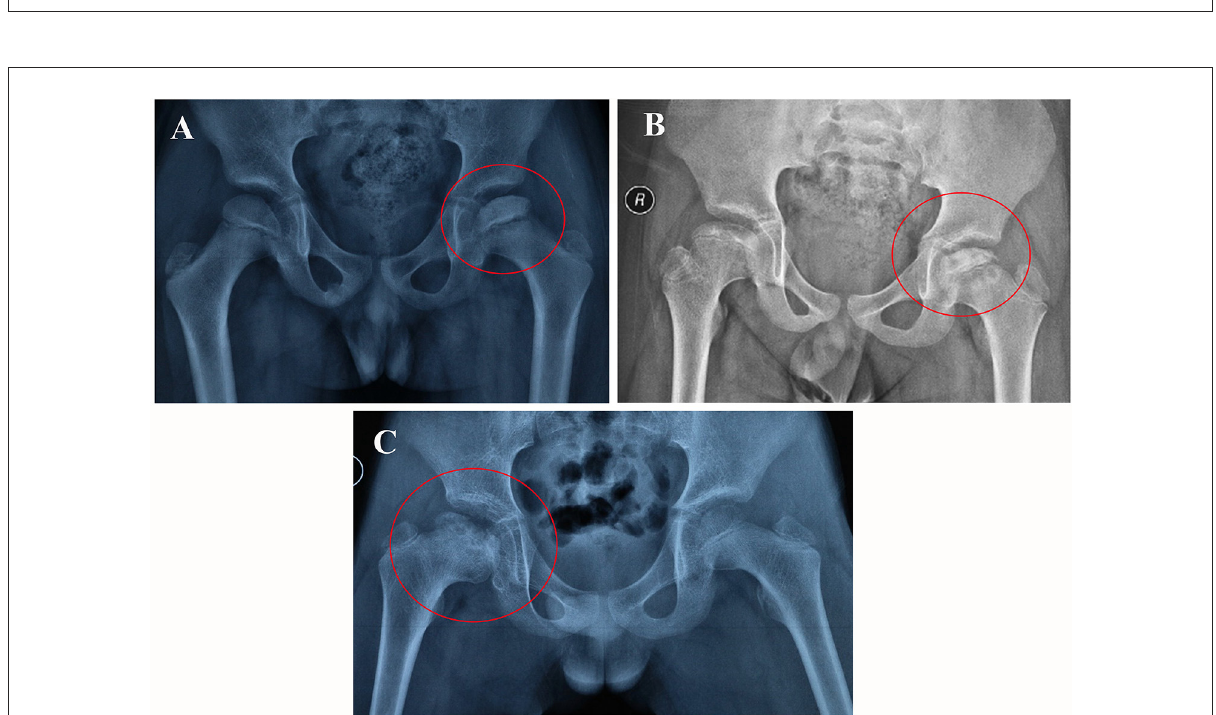
FIGURE10 The plain radiographic appearances of the femoral head from different stages of LCPD patients (the red circle). Necrosis stage, 8-year old boy involved left femoral head (A) ; Fragmentation stage, 9-year old boy involved both hip (B) ; Reossification stage, 10-year old boy involved right hip (C)